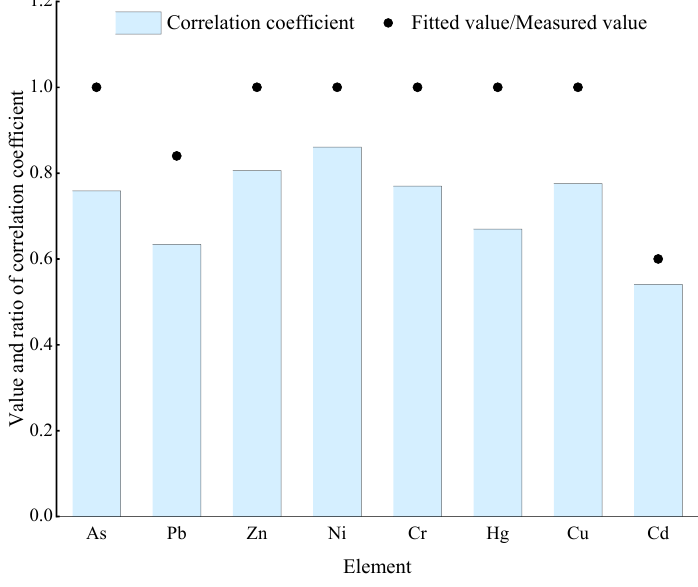
Figure 7. Accuracy characterization of APCS-MLR.